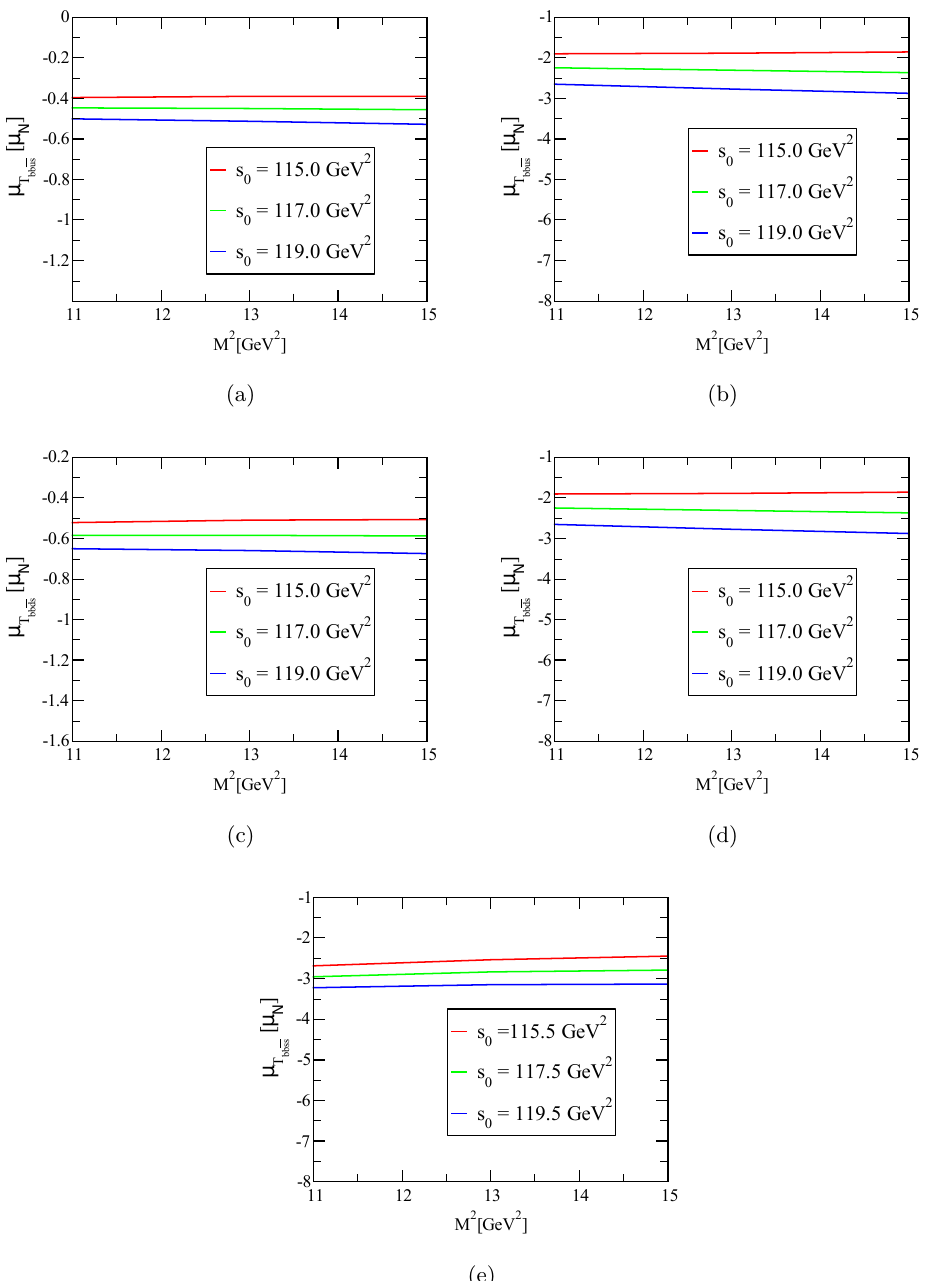
Figure 2 . Dependence of the MDMs of T bb ¯ q ¯ s and T bb ¯ s ¯ s tetraquark states on M 2 at three different values of s 0 ; (a) and (c) for the J 1 current; and (b), (d), and (e) for the J 3 µ